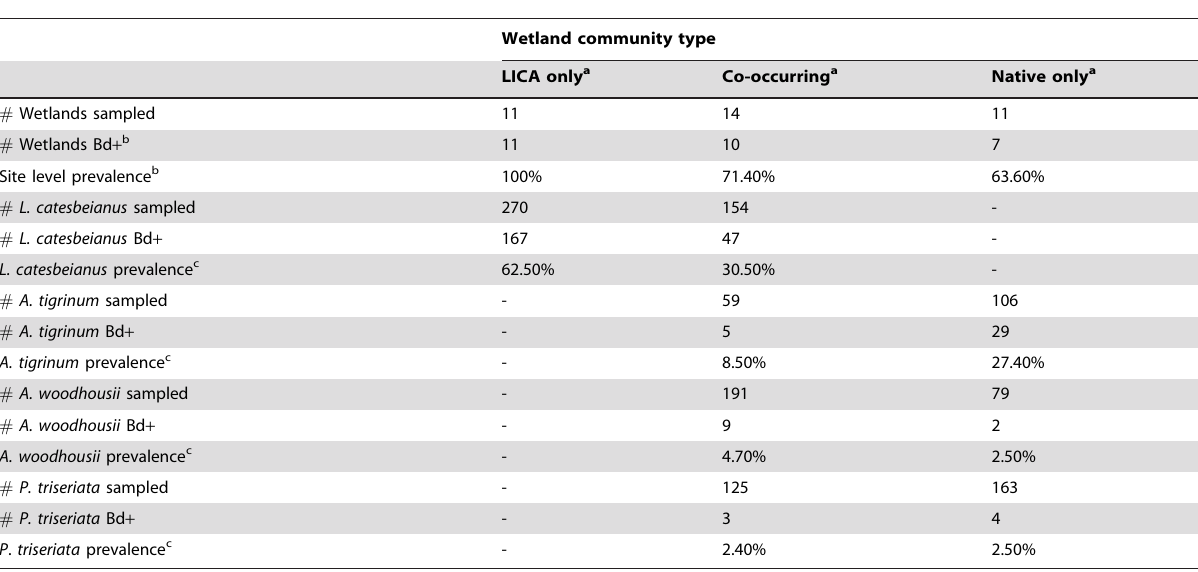
Table 2. Prevalence of Bd infection across amphibian communities and